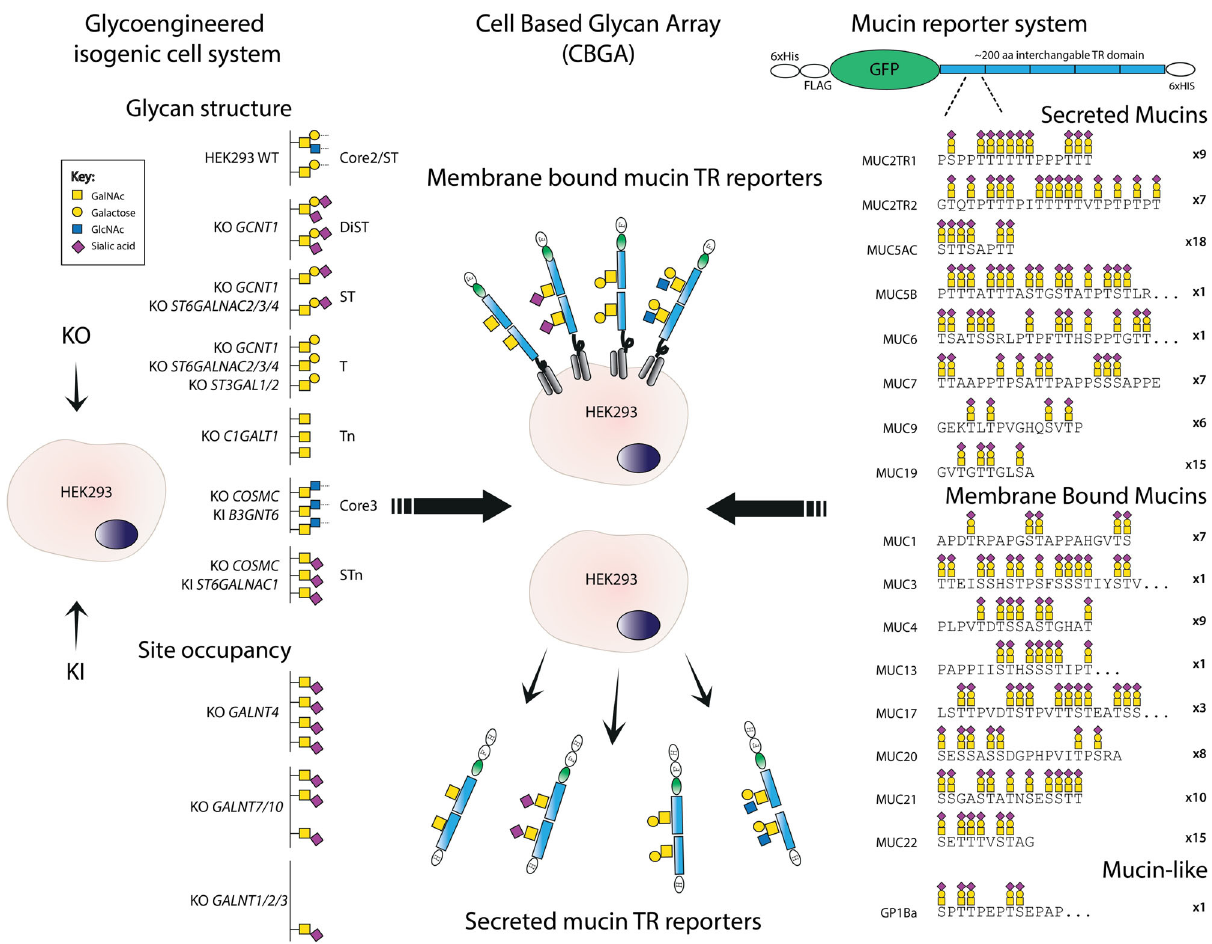
Fig. 1 Design of the human mucin tandem repeat (TR) display platform. Illustration of the mucin TR display approach with membrane-bound and secreted mucin reporters expressed in KO/KI glycoengineered isogenic HEK293 cell lines. HEK293 wild-type (WT) cells are predicted to produce a mixture of mSTa, dST, and sialylated core2 structures, and through stable genetic engineering, a library of isogenic HEK293 cells with different O-glycosylation capacities were developed. These cells enable the display of mucin TRs with different O-glycan structures as indicated (glycan symbols and genetic design shown), as well as tunable site occupancy by the engineering of the GALNT isoenzyme gene repertoire (left part). The secreted mucin reporter design contains an N-terminal 6xHis and FLAG tag, and GFP followed by different mucin TR domains of ca. 200 amino acids (single TR domains used for MUC3, MUC5B, MUC13, MUC6, and GP1b α ), and a second C-terminal 6xHis tag. The membrane-bound mucin reporters contain an N-terminal FLAG tag and GFP followed by the mucin TR domain and further includes the SEA and transmembrane domain of human MUC1 in the C-terminal end for membrane retention. The most characteristic TR sequence for each reporter is illustrated with the number of TRs included (right part). Full sequences of the TRs are shown in Supplementary Fig. 1. Transient or stable expression of the mucin TR reporters in the glycoengineered isogenic HEK293 cell library enables the display of cell surface mucin TRs as well as production of secreted mucin TRs with distinct O-glycan structures. Structures of glycans are shown with symbols drawn according to the Symbol Nomenclature for Glycans (SNFG) format 98